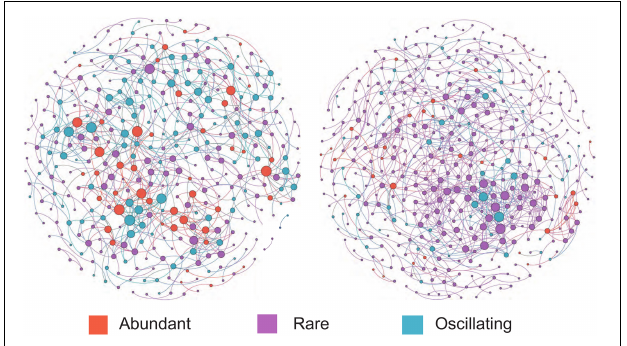
FIGURE 5 | Bacterial Co-occurrence networks for the communities before and after snowfall. Each node represents an amplicon sequence variant (ASV). Nodes are colored by abundant, rare, and oscillating taxa, and the node sizes were proportional to their node degrees. The community network after snowfall is more complex with a higher connectedness than before snowfall.